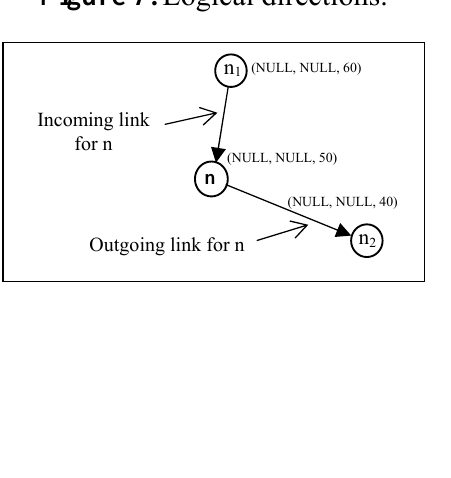
Figure 8. Concave node and dead end